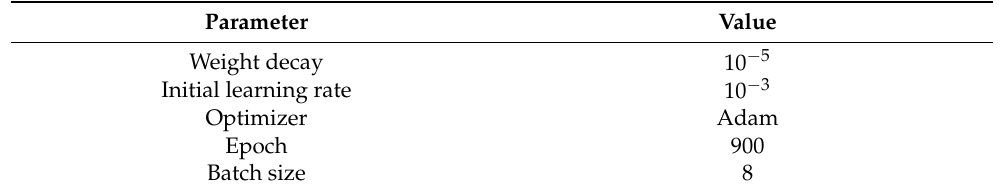
Table 2. Parameter settings during model